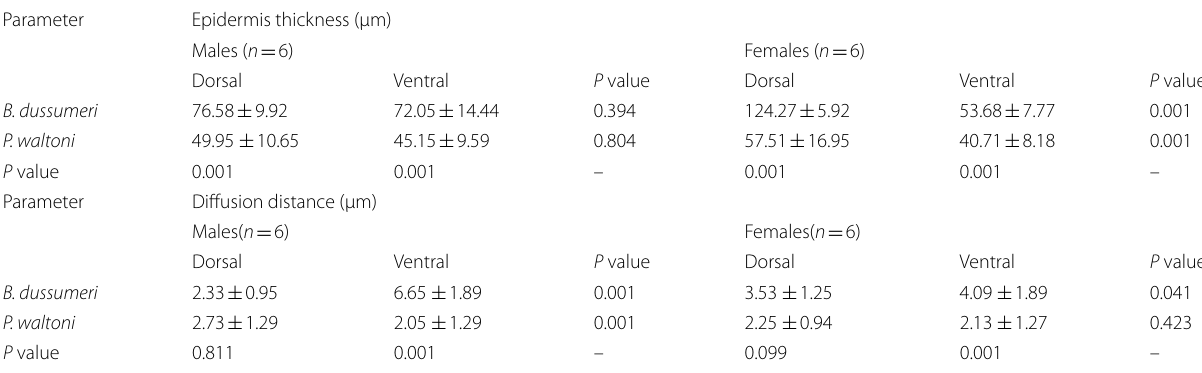
Table 3 The mean ( SD) epidermis thickness and diffusion distance in B. dussumeri and P. ±